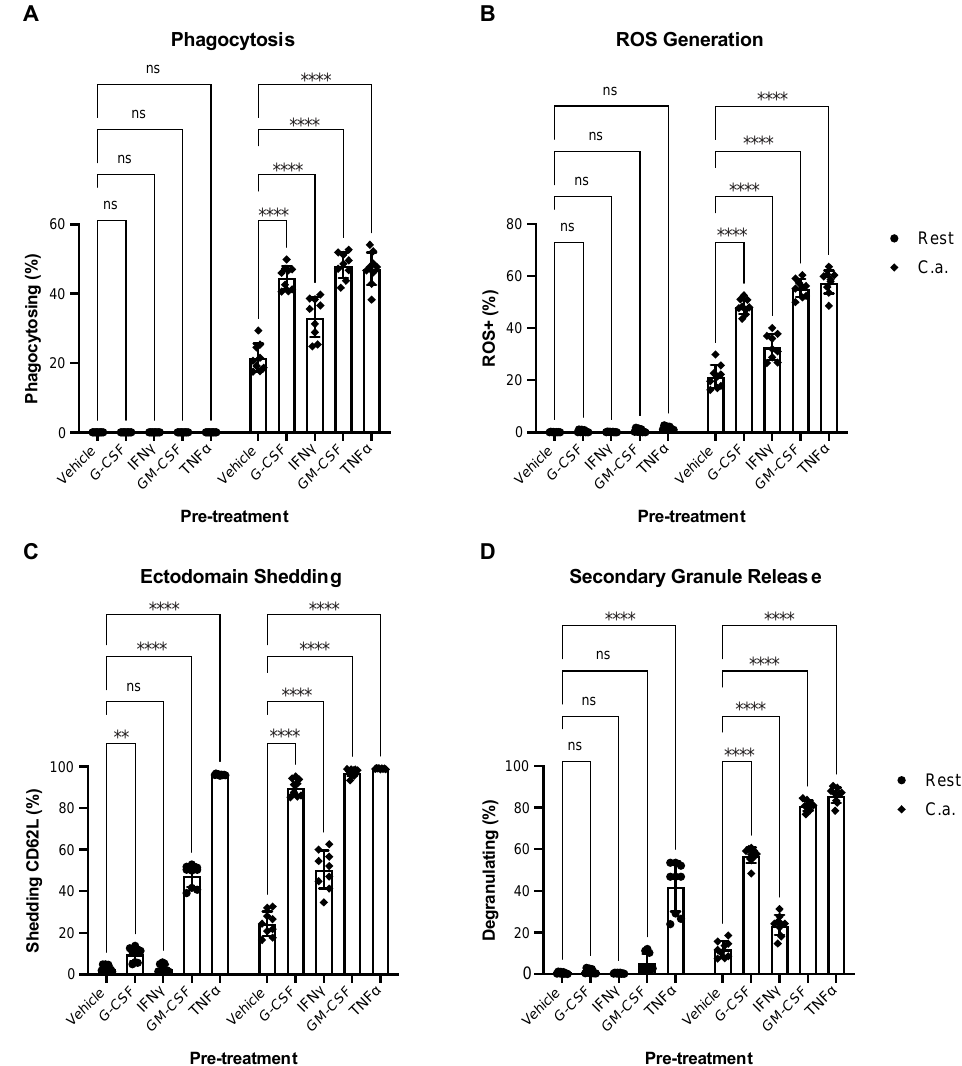
Figure 6. The multiparametric assay can detect functional augmentation. Neutrophils were pre- treated with pro-inflammatory cytokines G-CSF, IFN γ , GM-CSF, TNF α or vehicle control for 30 min to prime the neutrophils for enhanced functional output before coincubation with C. albicans (MOI of 2). The frequency of total neutrophils performing phagocytosis ( A ), ROS generation ( B ), ectodomain shedding ( C ), or secondary degranulation ( D ) was measured at rest (Rest) and after co-culture (C.a.). Data are represented as mean ± SD; n = 3 per group in each experiment per donor; experiments were repeated three times with three different donors. Data were analyzed by one-way ANOVA with a Tukey posttest. ** p < 0.0021, **** p < 0.0001.